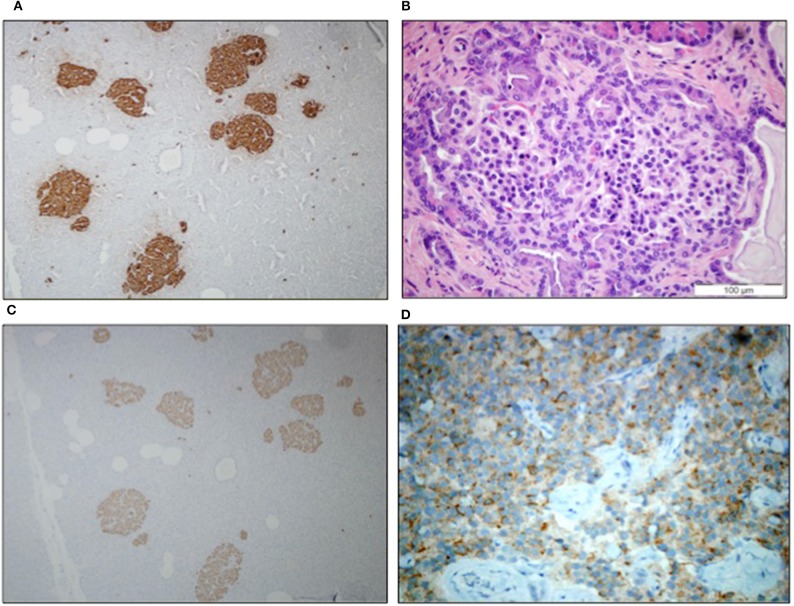
(A) Immunostaining of chromogranin highlighted the enlarged and irregular islets (10x); (B) ductuloinsular complexes haematoxylin-eosin staining (40x); (C) islets with diffuse positivity for insulin (10x); and (D) neuroendocrine tumor immunoreactive for insulin (10x).